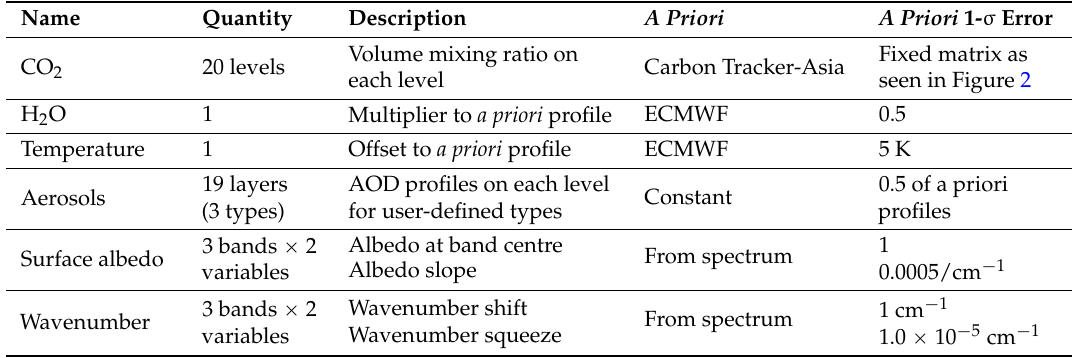
Table 2. State vector composition of the YCAR algorithm. ECMWF, European Centre for Medium-Range Weather Forecasts; AOD, Aerosol Optical